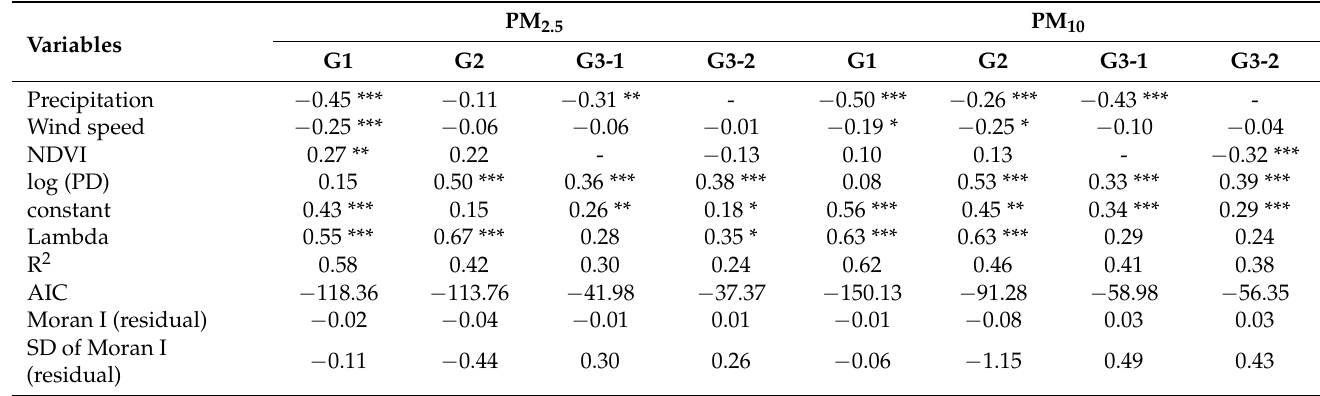
Table 4. SEM regression results of PM 2.5 and PM 10 in each